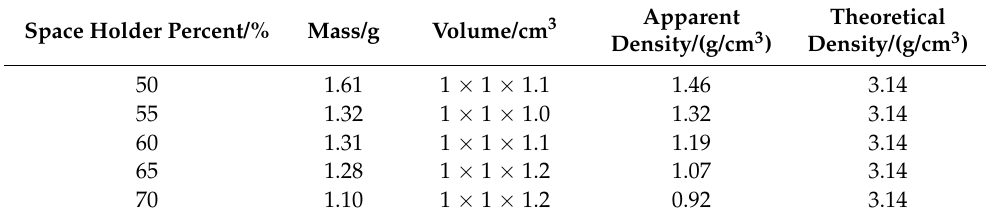
Table 2. The mass, volume, apparent density and theoretical density of the 20Zr samples with different space holder percentages.